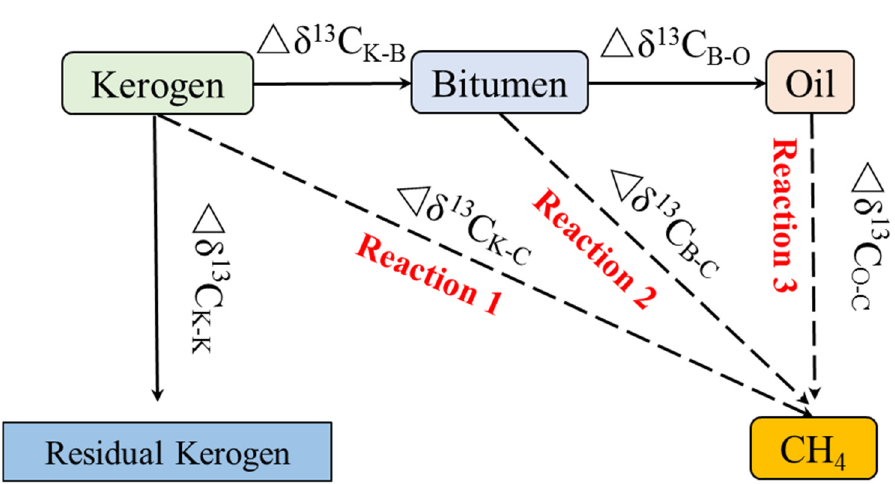
Figure 8. The schematic diagram of the methanogenesis pathway and corresponding carbon isotope variation.